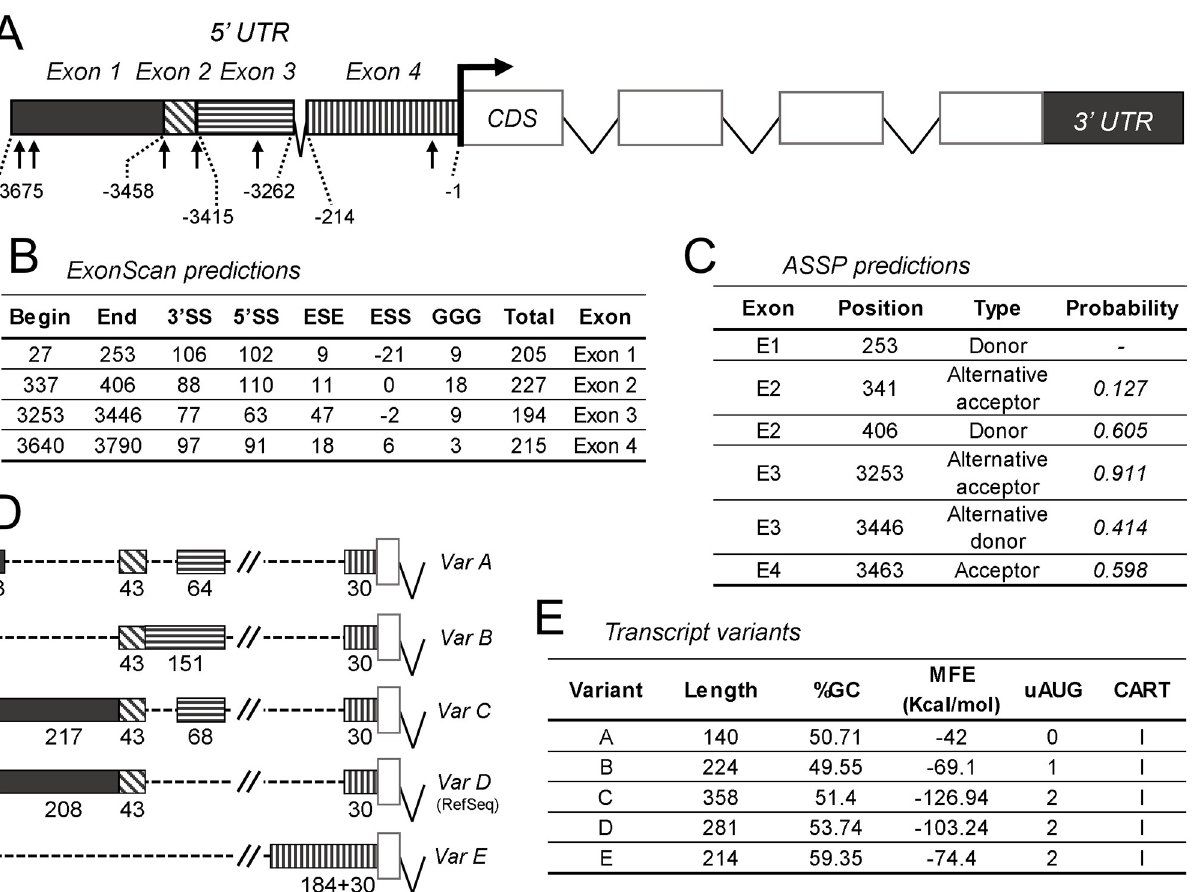
Fig 2. Bioinformatic analyses of mouse ApoD 5’ UTR region. A) Predicted exonic structure of mouse ApoD 5’ UTR region. Arrows point to predicted splice sites. Exon boundaries are marked by numbers in relation to the ORF. B) ExonScan prediction of potential exonic 5’ UTR sequences. 5’SS (donor) and 3’SS (acceptor) indicate probabilities of splice sites in comparison to decoy at both ends. ESE (exonic splicing enhancers) values are the estimated odd of a given string being an exon relative to being an intron. ESS (exonic splicing silencers) values are the estimated odd of being a pseudoexon in contrast to being an exon. Intronic GGG takes a small constant value when located 100–40 bases upstream or 10–70 bases downstream a candidate exon. Total refers to the sum of scores for every candidate exon. C) ASSP classification and estimated probability of predicted exonic 5’ UTR sequences. Both ExonScan and ASSP predictions are very similar. D) Exon composition of the transcriptional variants of mouse ApoD 5’ UTR annotated in AceView database. E) Primary and secondary structure properties of mouse ApoD 5’ UTR variants, including estimated minimal folding energy (MFE), number of upstream AUG codon (uAUG) and class resulting from the classification and regression tree (CART) method.